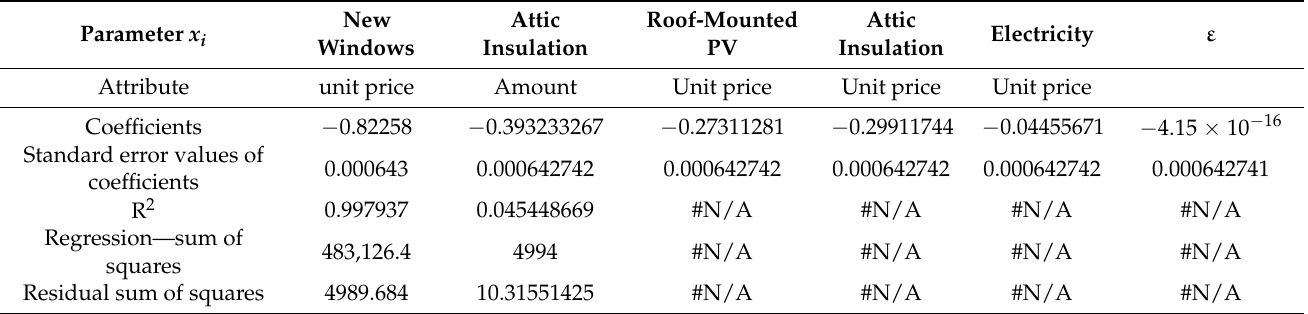
Figure A2. Left: histogram representation of resulting NPV for gas. Right: resulting share of regres- sion coefficients and R 2 value of the linear approximation. Table A2. Regression parameters for calculation model with gas.